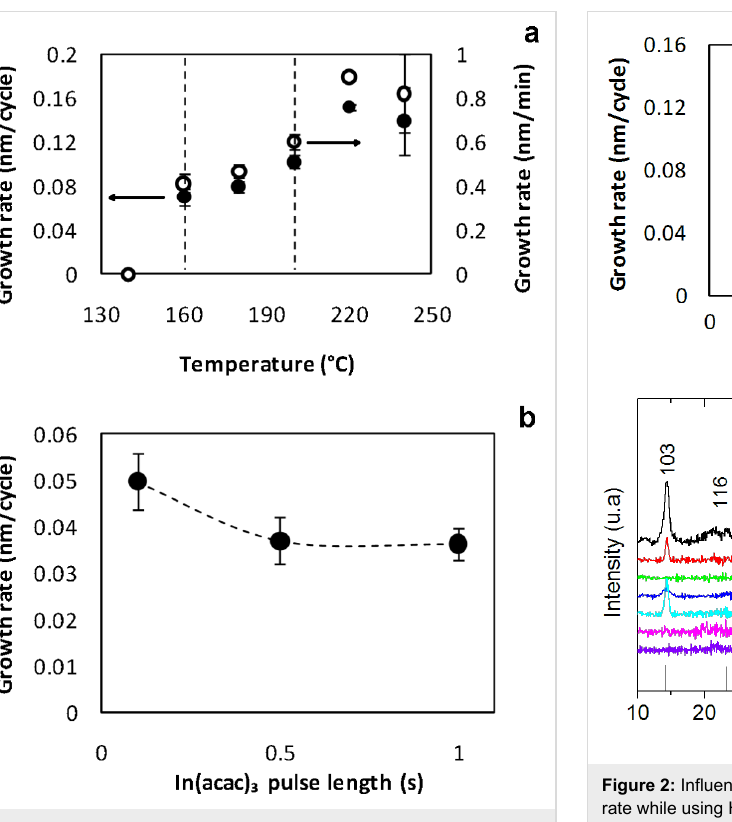
Figure 1: Growth rate of pure In 2 S 3 a) as function of the process temperature b) as function of the In(acac) 3 pulse length.